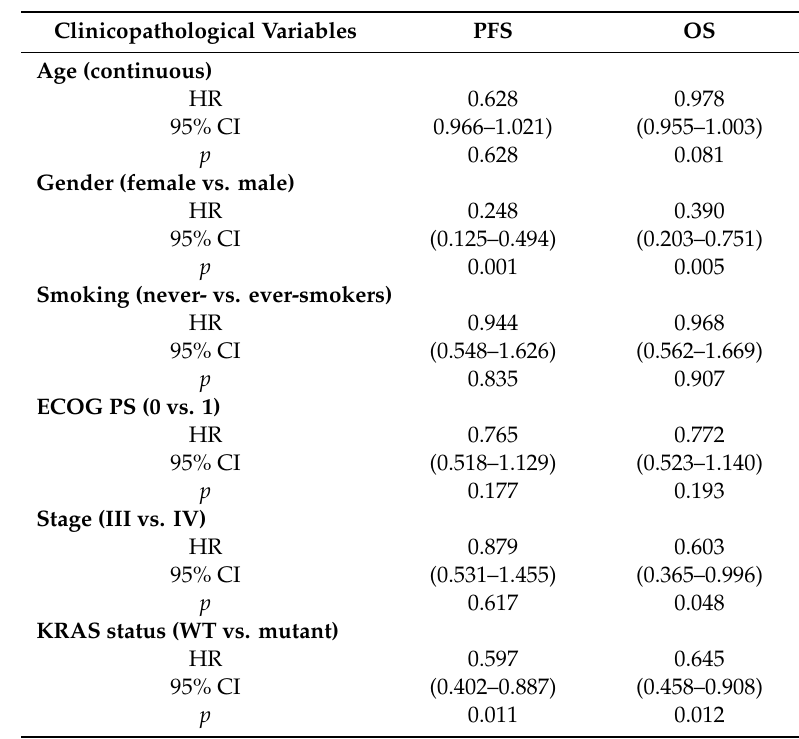
Table 2. Clinicopathological variables and progression-free survival (PFS) and overall survival (OS) of lung adenocarcinoma (LADC) patients treated with bevacizumab / chemotherapy (BEV / CHT) in the multivariate Cox proportional hazards